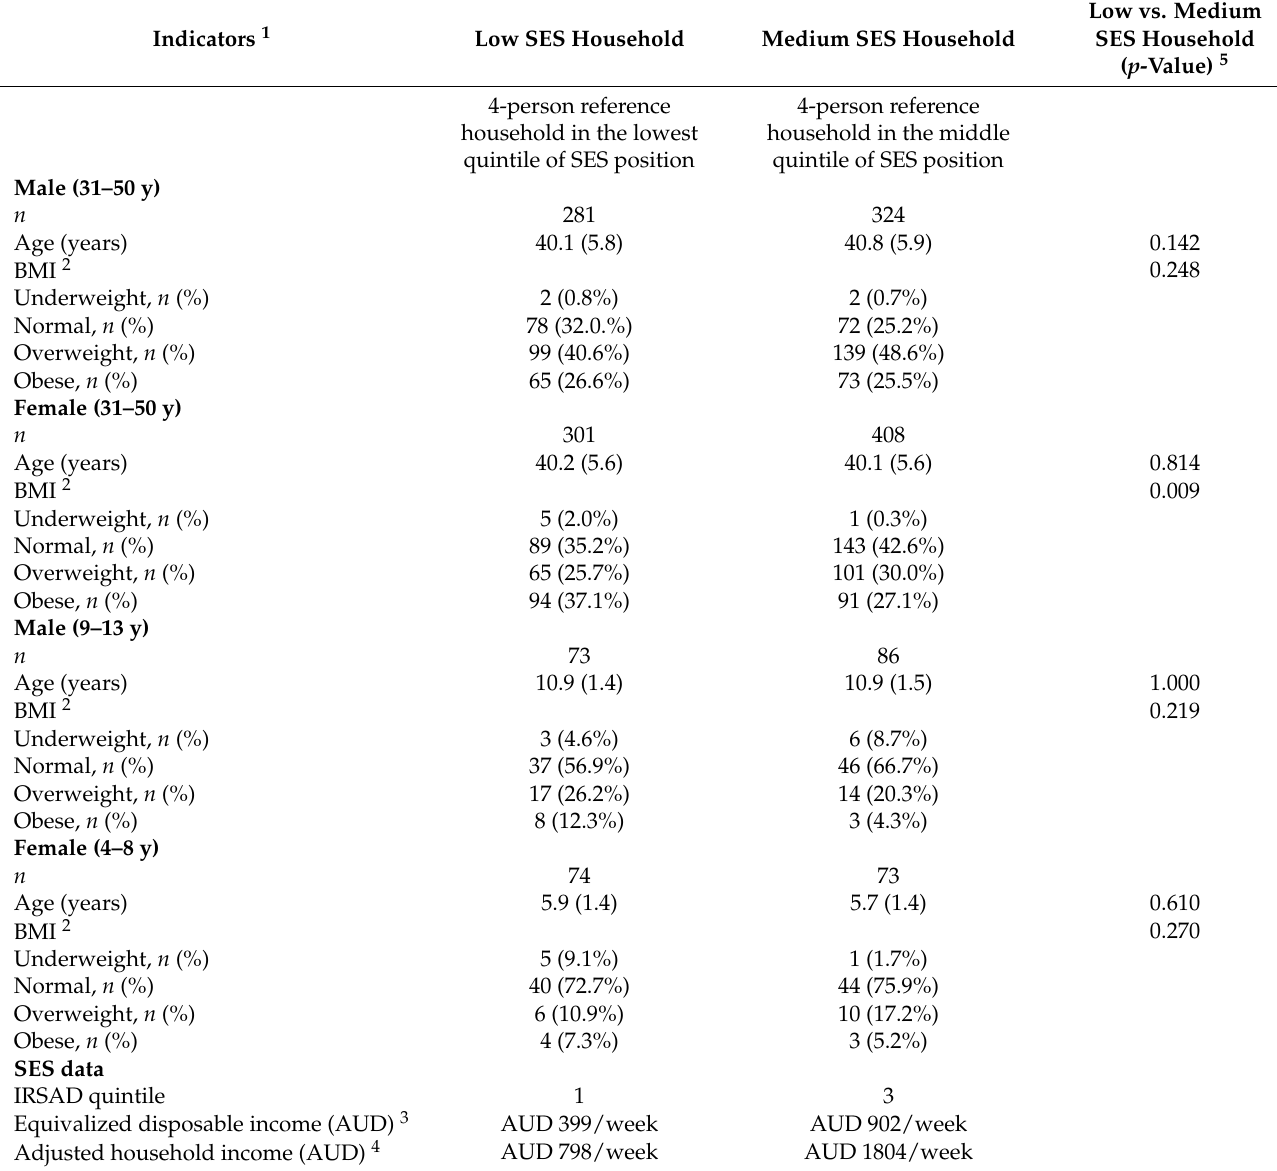
Table 2. Demographics of low and medium SES reference